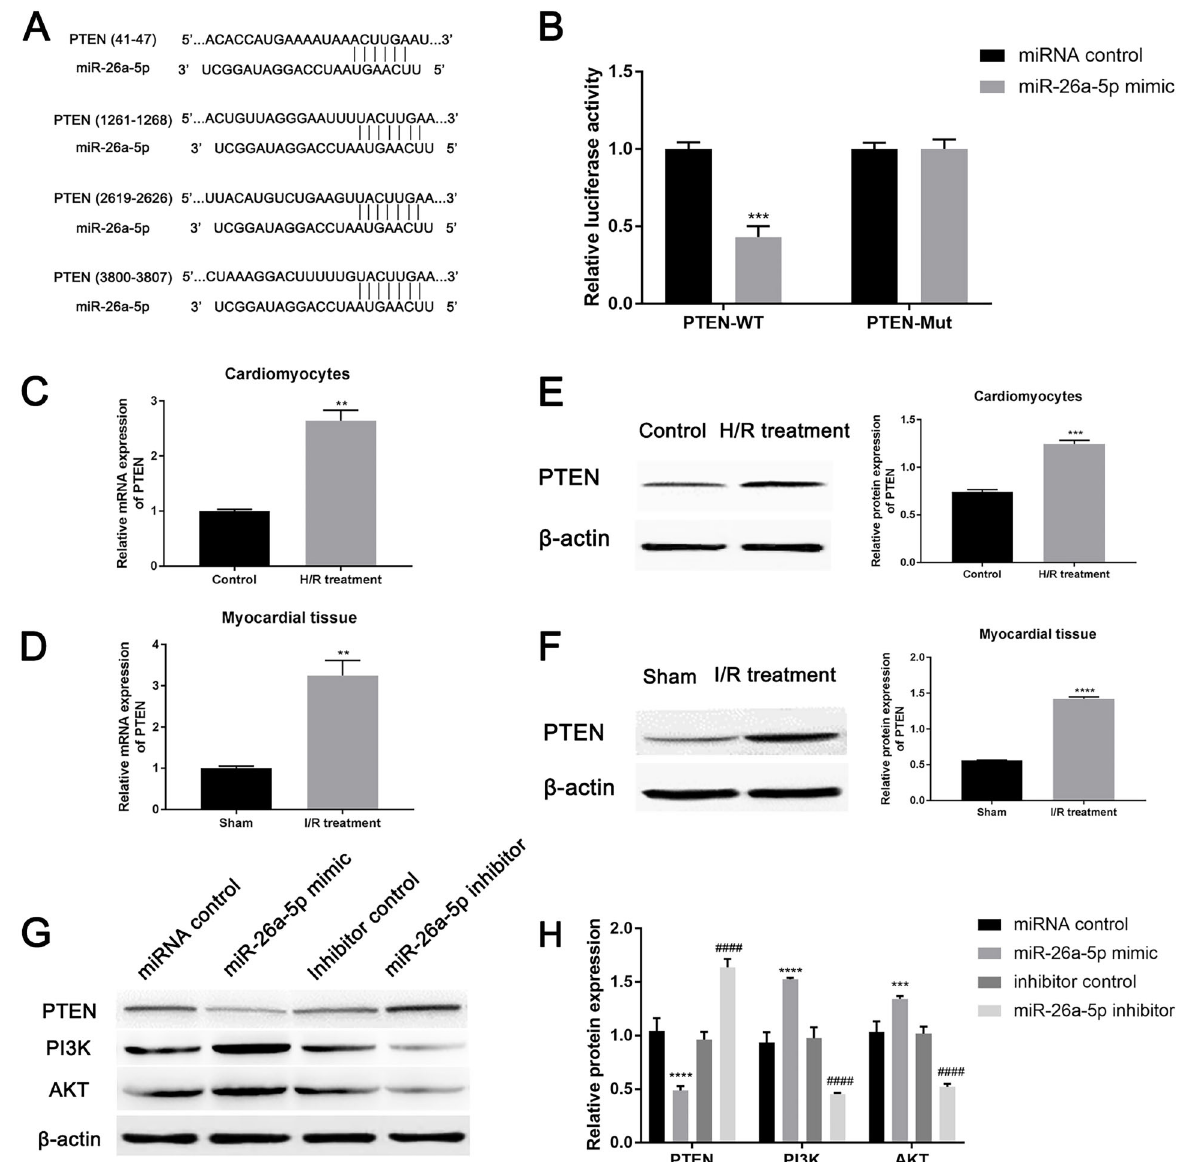
Figure 4. Interaction between miR-26a-5p and PTEN. A , Binding sites between miR-26a-5p and PTEN. B , Luciferase reporter assay measured the luciferase activity of PTEN-WT (wild type) or PTEN-Mut (mutant) vector. The mRNA and protein expression of PTEN in ( C and E ) cardiomyocytes after hypoxia/reoxygenation (H/R) and ( D and F ) myocardial tissue upon ischemia/reperfusion (I/R) injury was measured by qRT-PCR and western blot, respectively. After transfection of four different miR-26a-5p vectors, the expression of PTEN, PI3K, and AKT was evaluated by ( G ) western blot and quanti fi ed by ( H ) ImageJ software. Data are reported as means ± SD. **P o 0.01, ***P o 0.001, ****P o 0.0001 vs control groups; #### P o 0.0001 vs inhibitor control ( t -test or